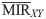
Network inference in the case of two, disconnected, triplets of nodes.Panel (a) shows the network of weakly coupled (α = 0.1) logistic maps. Nodes 1 and 3 interact indirectly through node 2, and similarly, nodes 4 and 6 through node 5. Panel (b) shows the ordered MIR¯XY and threshold τ (red dash line) when no additional nodes are introduced to the network. The red dash line corresponds to τ ≈ 0.16. Panel (c) shows the unsuccessfully inferred network when using only the data from the network in panel (a). Panel (d) shows the ordered MIR¯XY values for the same network as in (a) with the additional data from the pair of directed nodes (see text). The blue dash line represents the threshold computed for the pair of directed nodes (τ ≈ 0.69) and the red dash line corresponds to τ ≈ 0.16 from panel (b). Finally, panel (e) shows the successfully inferred network by considering as connected nodes only those with MIR¯XY bigger than the blue dash threshold.